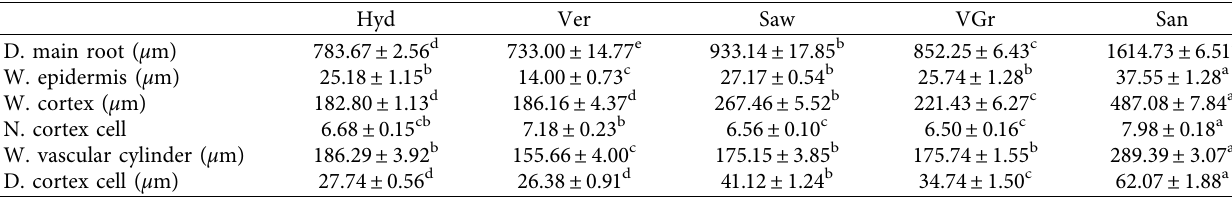
Figure 3: Root system architecture of cedar seedlings growing on five media with different hydromechanical constraints: (a) Hyd, (b) Ver, (c) Saw, (d) VGr, and (e) San. The scale bar corresponds to Table 3: Dimensions of various root anatomical structures.